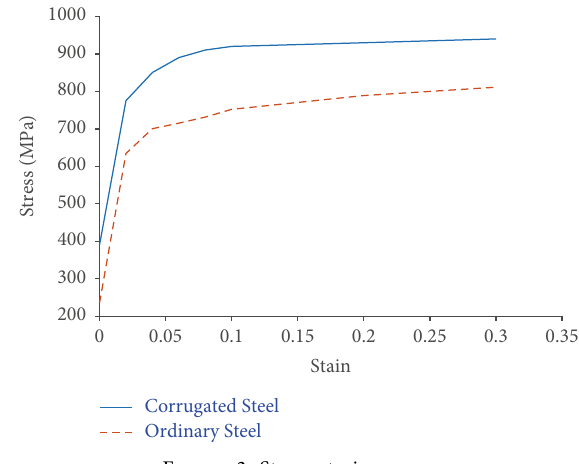
Figure 3: Stress-strain